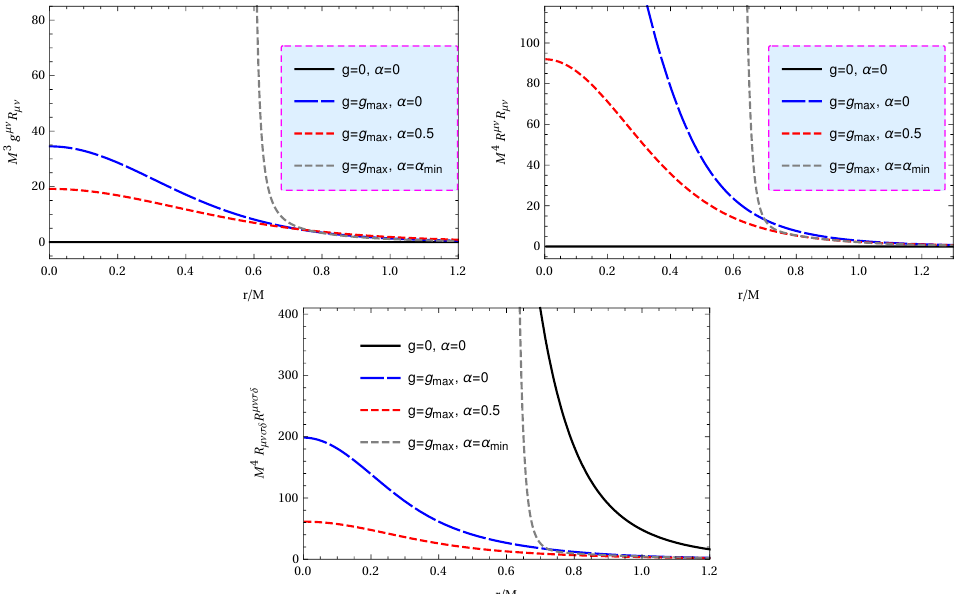
Figure 4. Dimensionless Ricci scalar ( left panel), square of Ricci tensor ( right panel) and Kretschmann scalar ( bottom panel) as a function of dimensionless radial coordinate r / M for different values of the RBH parameters g and α